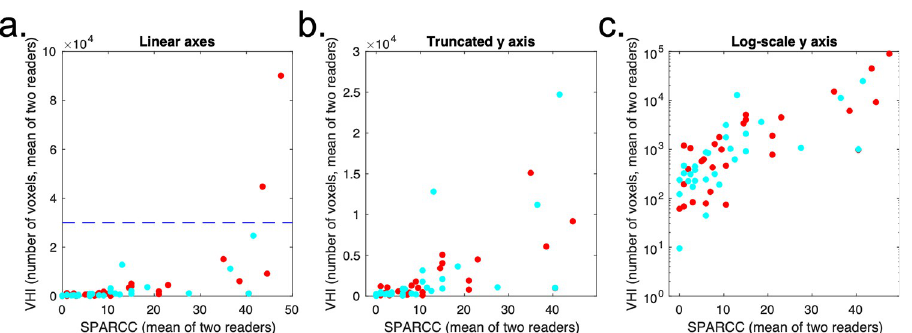
Fig 6. Relationship between VHI and conventional visual scoring. The raw voxel counts (left column), voxel counts with truncation of the y-axis (middle column) and voxel counts with log(x+1) transformation (right-hand column) are shown on scatterplot. The truncation point used to generate (b) is shown on (a) as a blue dotted line. Note that the relationship between SPARCC scoring and inflammation volume is nonlinear but becomes approximately linear with log(x+1) transformation. Red points refer to pre-treatment scans, and blue points to post-treatment scans. R1 and R2 refer to reader 1 and reader 2.